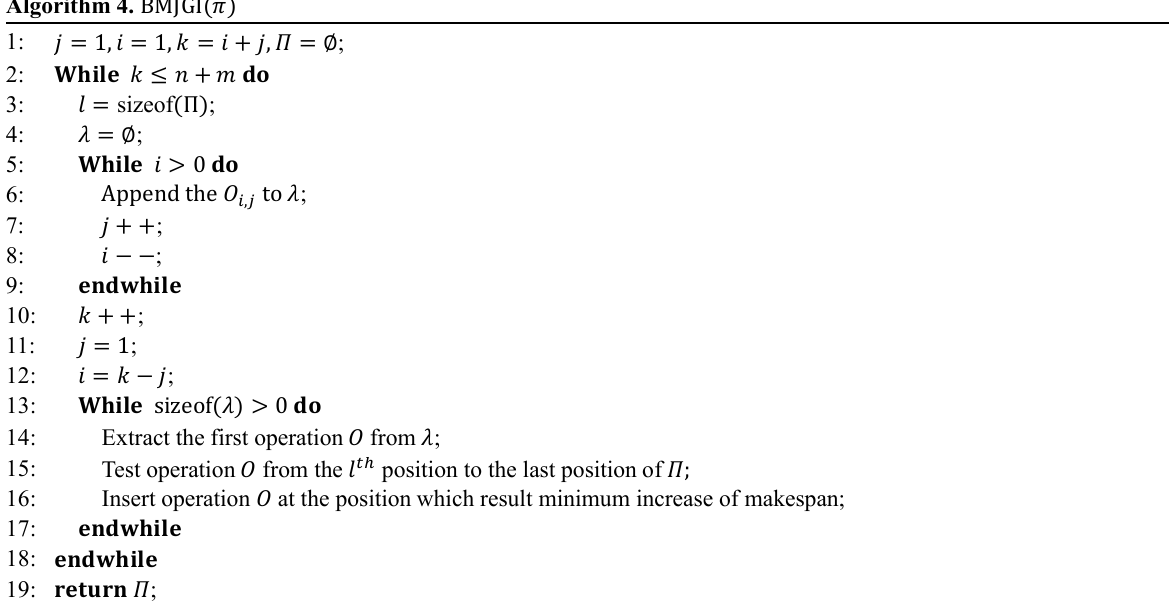
Algorithm 4. BMJGI( 𝜋 )